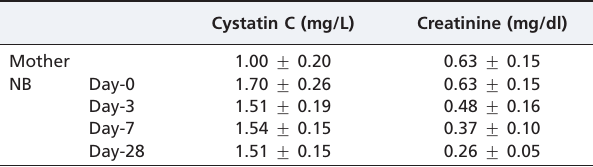
Table 4 - Levels of cystatin C and